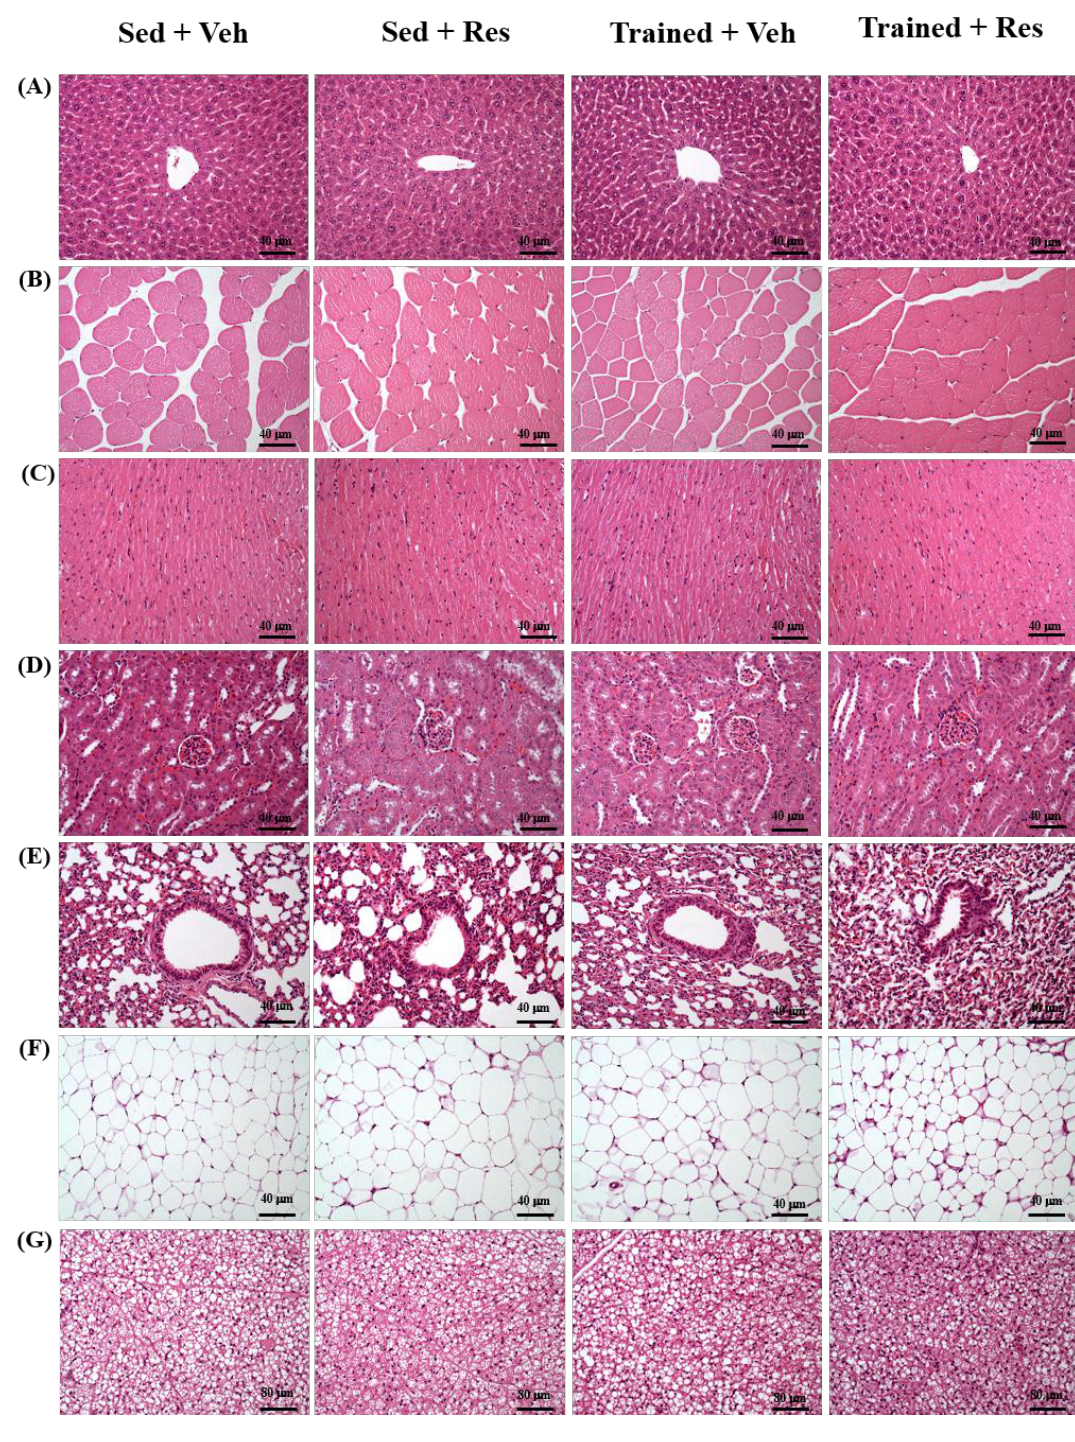
Figure 7. Effect of climb training (Trained) and/or resveratrol (RES) supplementation on the morphology of ( A ) liver; ( B ) skeletal muscle; ( C ) heart; ( D ) kidney; and ( E ) lung ( F ) white adipose tissue (WAT) ( G ) brown adipocytes (BAT) in mice. Specimens were photographed using light microscopy. (Hematoxylin and eosin stain, magnification: 200×; scale bar, 40 or 80 μm).